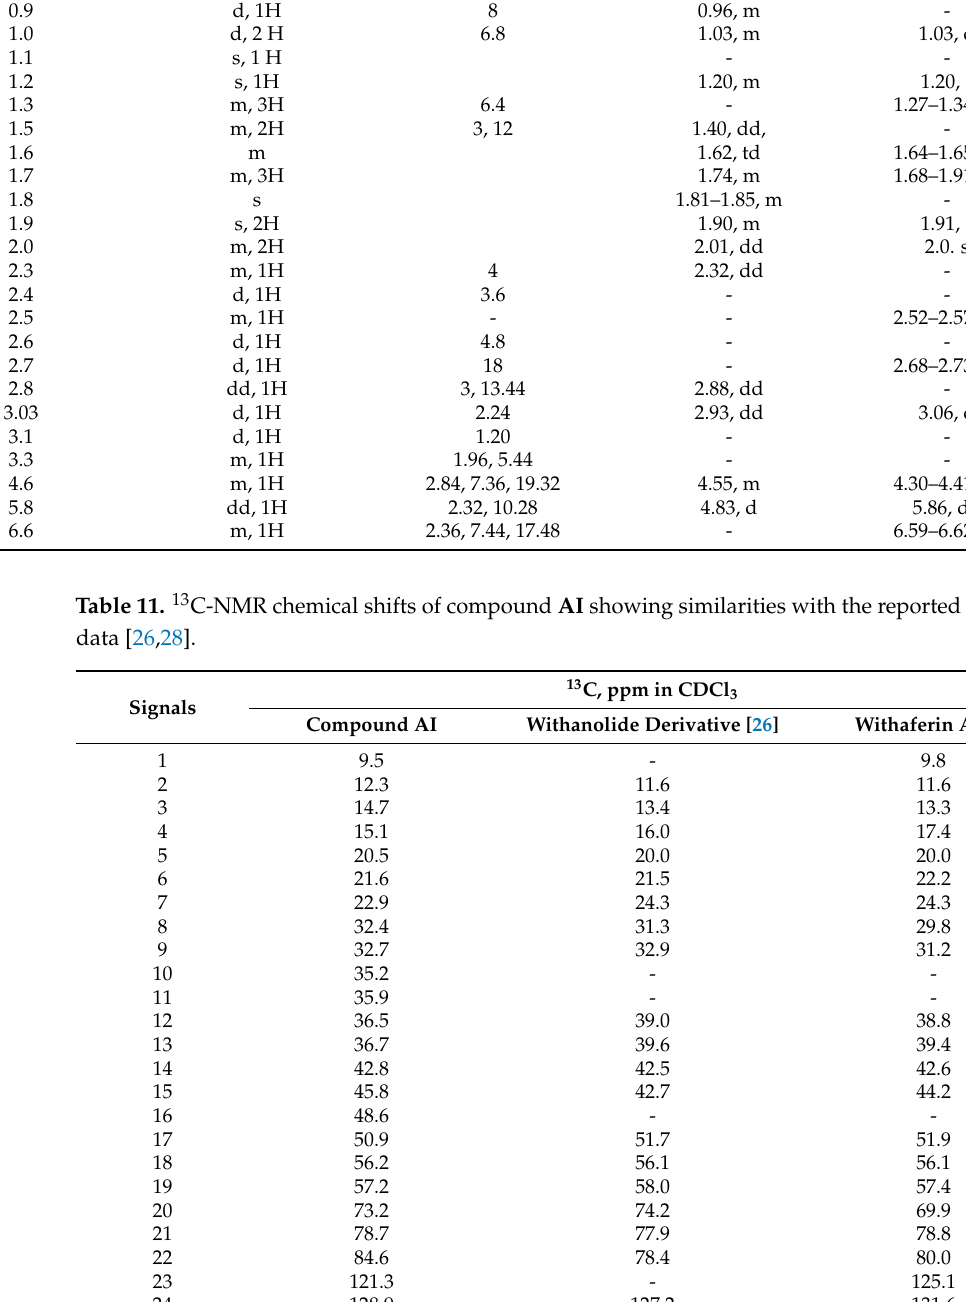
Table 10. 1 H-NMR chemical shifts of compound AI showing similarities with the withanolide derivative data [26,27]. Compound AI Signals Chemical Shift ( δ H, ppm in CDCl 3 )